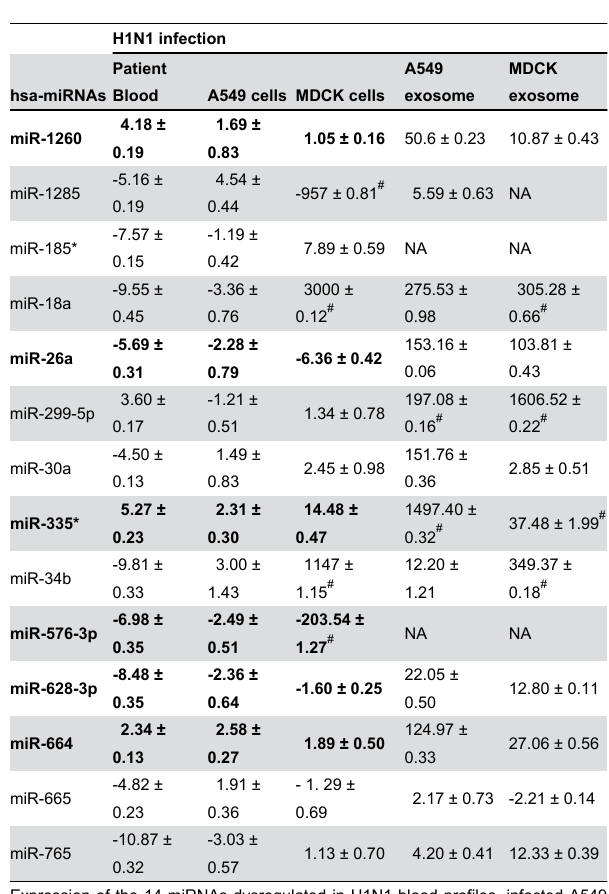
Table 2. Fold change of miRNA